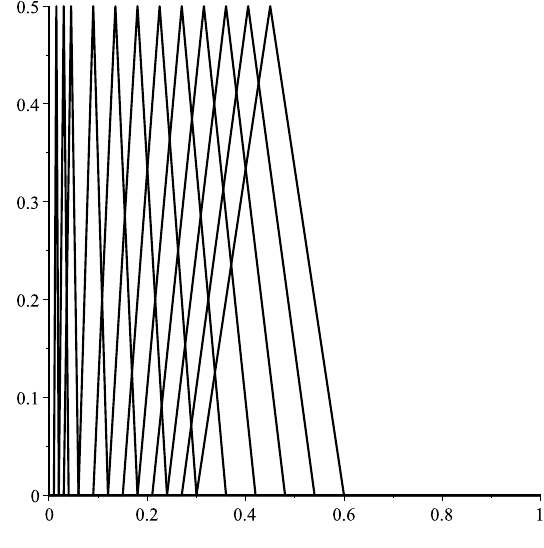
Figure 7. Membership degrees µ ( x ) , for all x ∈ ( 0,3 ) .